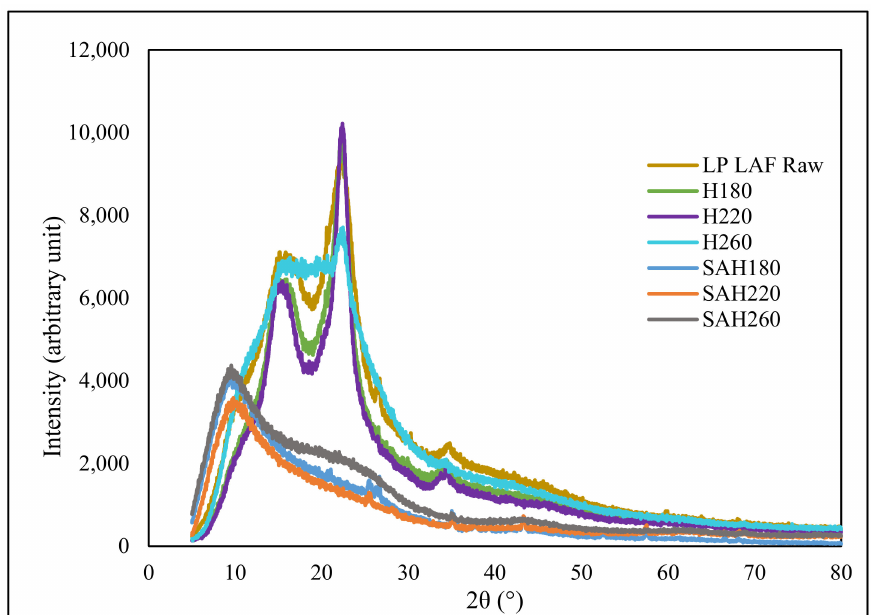
Figure 1. XRD diffractions patterns of loblolly pine biomass, hydrochars (H180, H220, H260) and corresponding activated hydrochars (SAH180, SAH220, SAH260).